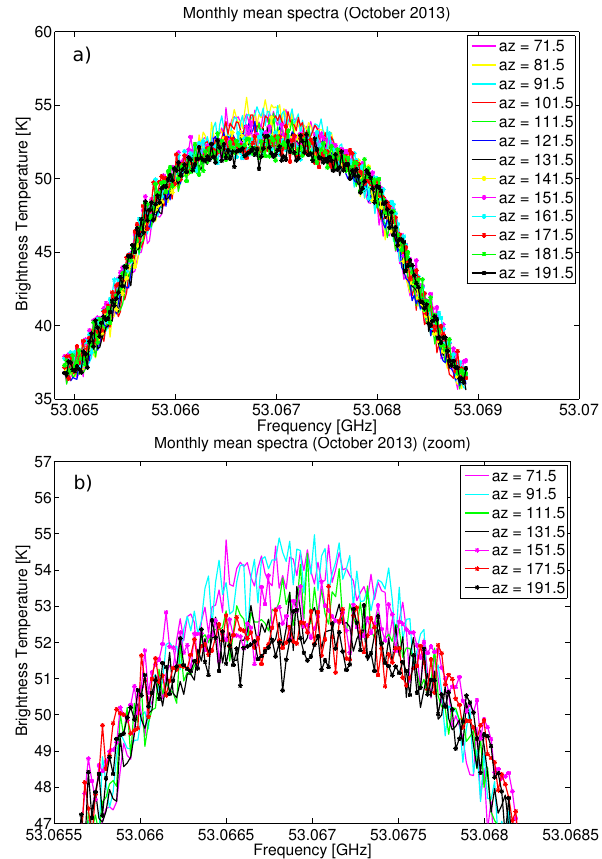
Figure 11. Monthly brightness temperature from SDR corrected for tropospheric effects (October 2013). Fig. 11. Monthly Brightness temperature from SDR corrected of tropospheric effects (October 2013).